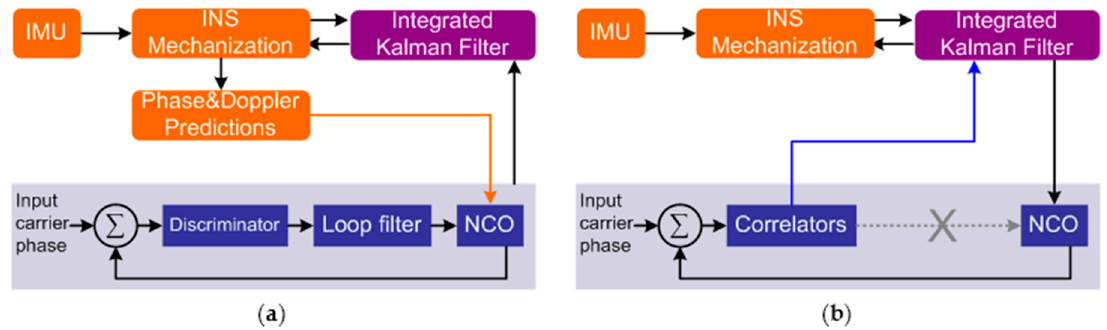
Figure 1. Two architectures of global navigation satellite systems (GNSS)/inertial navigation system (INS) deep integration. ( a ) Scalar-based architecture; ( b ) vector-based architecture. NCO, numerically-controlled